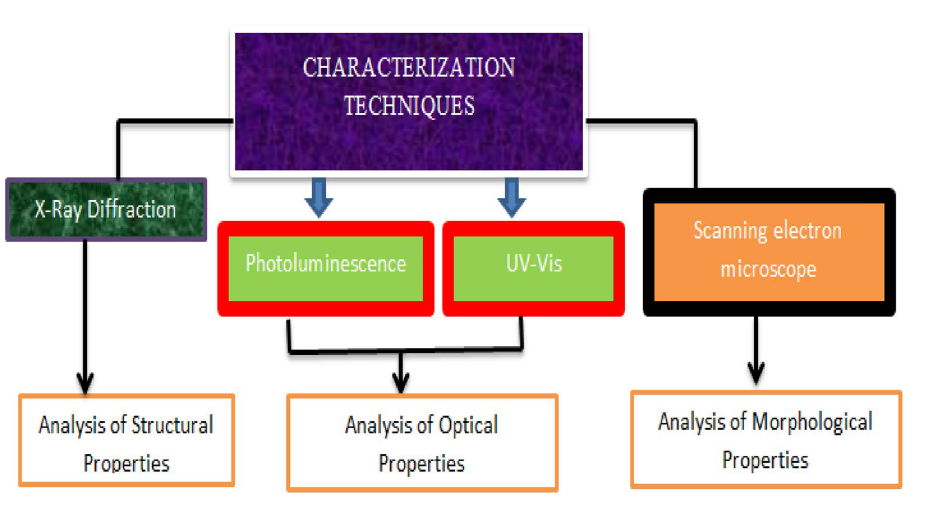
Figure 2. Characterization techniques and their